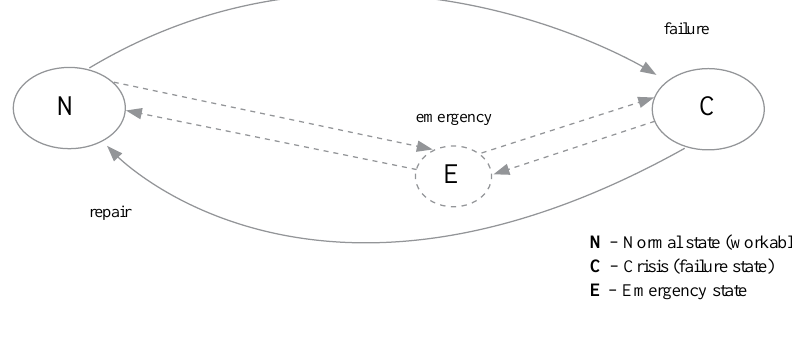
Fig. 5. Supply system